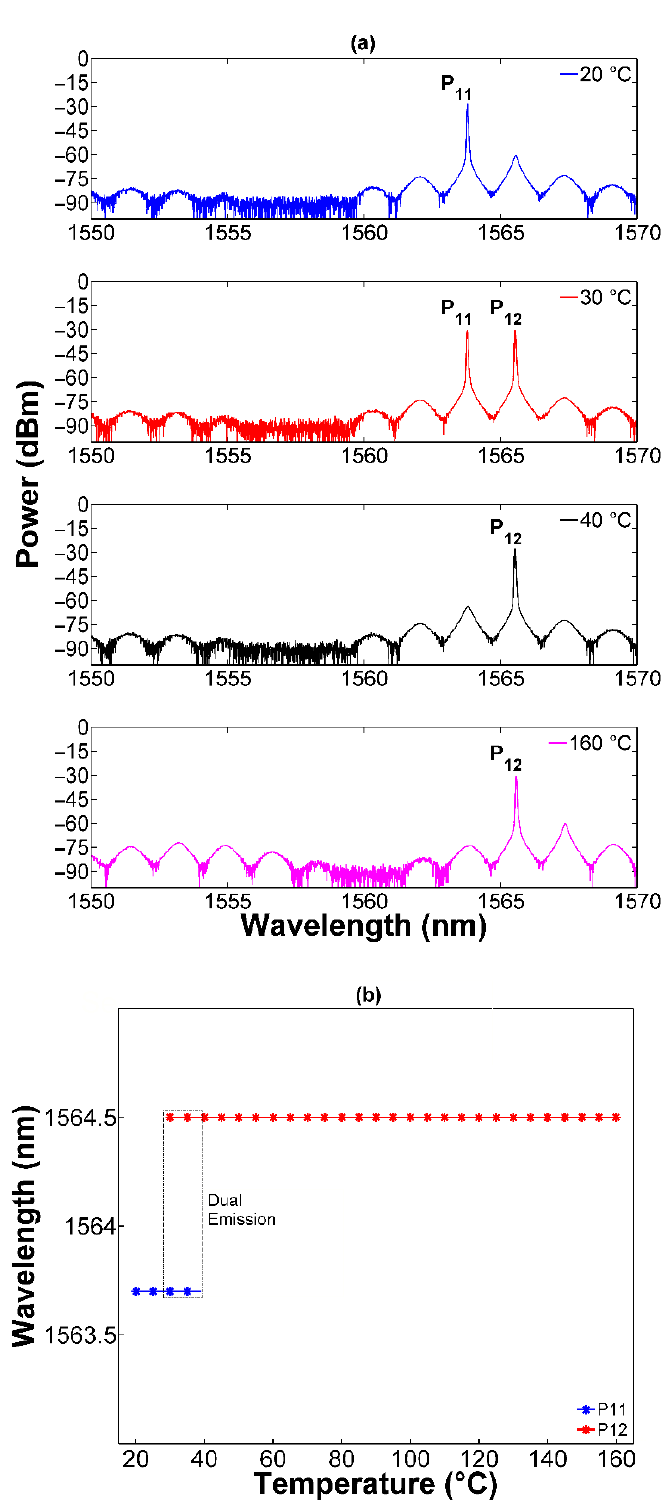
Figure 5. Switchable operation of the EDFL using MZI 2 and MZI 1a in a cascade configuration, withstanding temperature variations between 20 to 160 ◦ C. ( a ) Laser emissions and ( b ) stability analysis of laser emissions against temperature